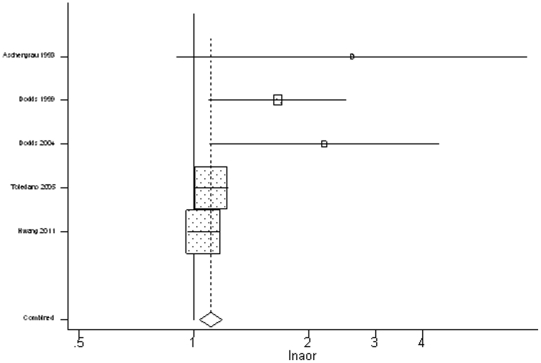
Tree Plots of Study-specific and Summary Effect Estimates for all available studies.